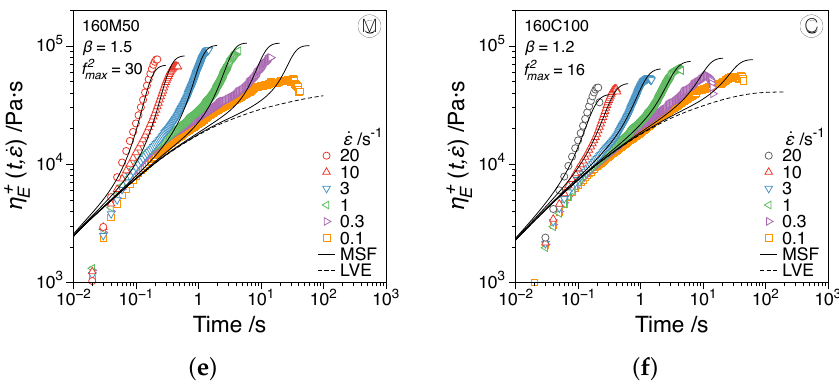
Figure 7. Extensional measurements (symbols) and the MSF theory predictions (solid lines) for ( a ) EBA, ( b ) EBA-GnP(1), ( c ) EBA-GnP(2), ( d ) 180C50 ( e ) 160M100 and ( f ) 160C100. The EBA-GnP(2) contains 9.5 vol% of GnP and was analyzed in order to test the limits of the strain hardening behavior. The dashed line, LVE, represents the linear viscoelastic envelope.